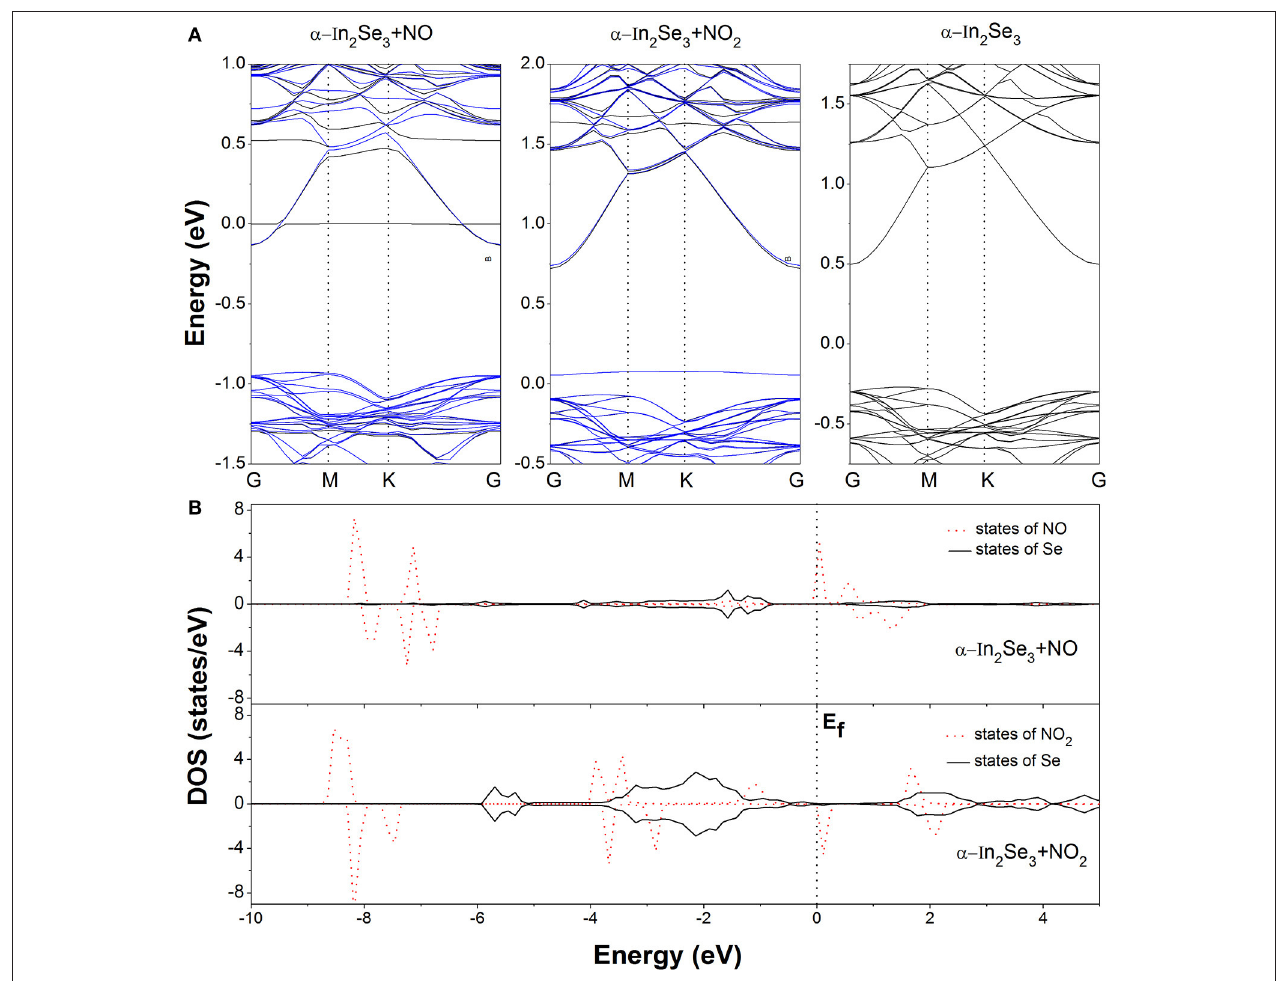
FIGURE 3 | (A) The band structures of the clean α -In 2 Se 3 monolayer and the most stable configurations of the α -In 2 Se 3 monolayer adsorbed by NO and NO 2 . For the two adsorption cases, the black and blue curves represent the spin up and spin down bands, respectively. (B) The local density of states (DOS) of the adsorbed molecules and the Se atoms near them. The Fermi level is set as